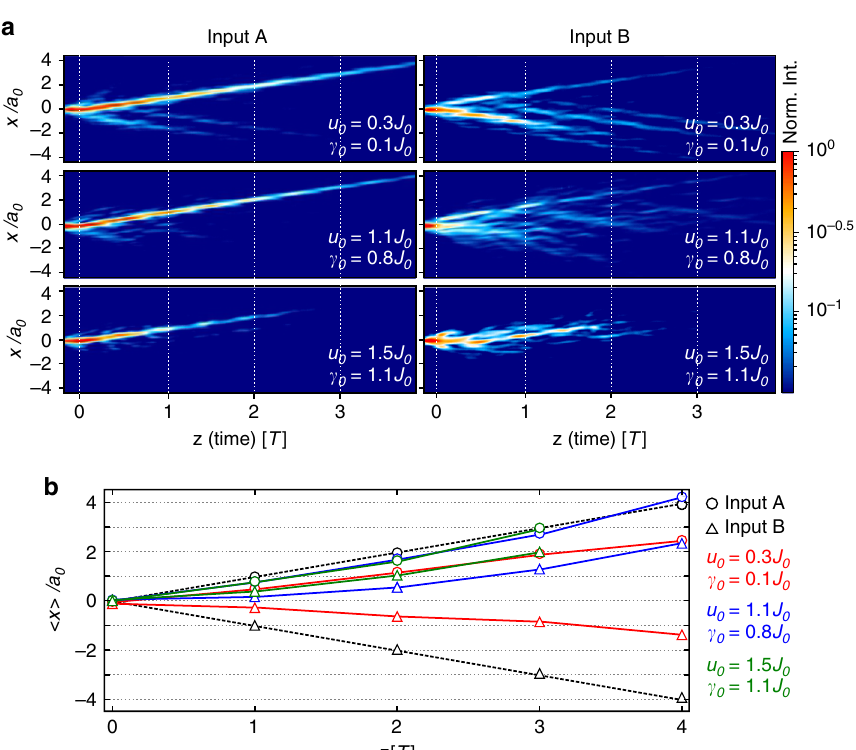
Fig. 7 In fl uence of cross-section modulation and input conditions on the transport. a Real-space SPP intensity distributions for the arrays with different strengths of the cross-section modulation ( u 0 = 0.3 J 0 , γ 0 = 0.1 J 0 ), ( u 0 = 1.1 J 0 , γ 0 = 0.8 J 0 ), and ( u 0 = 1.5 J 0 , γ 0 = 1.1 J 0 ). Measurements on the left-hand side show the SPP propagation after excitation at sublattice A (low-loss input). Measurements on the right-hand side show the SPP propagation after excitation at sublattice B (high-loss input) ( b ) The CoM position of the SPP intensity in dependence on propagation distance z calculated from the experimental results shown in a . Note that the z -axis here is normalized to the period T . The black dashed line shows the anticipated adiabatic